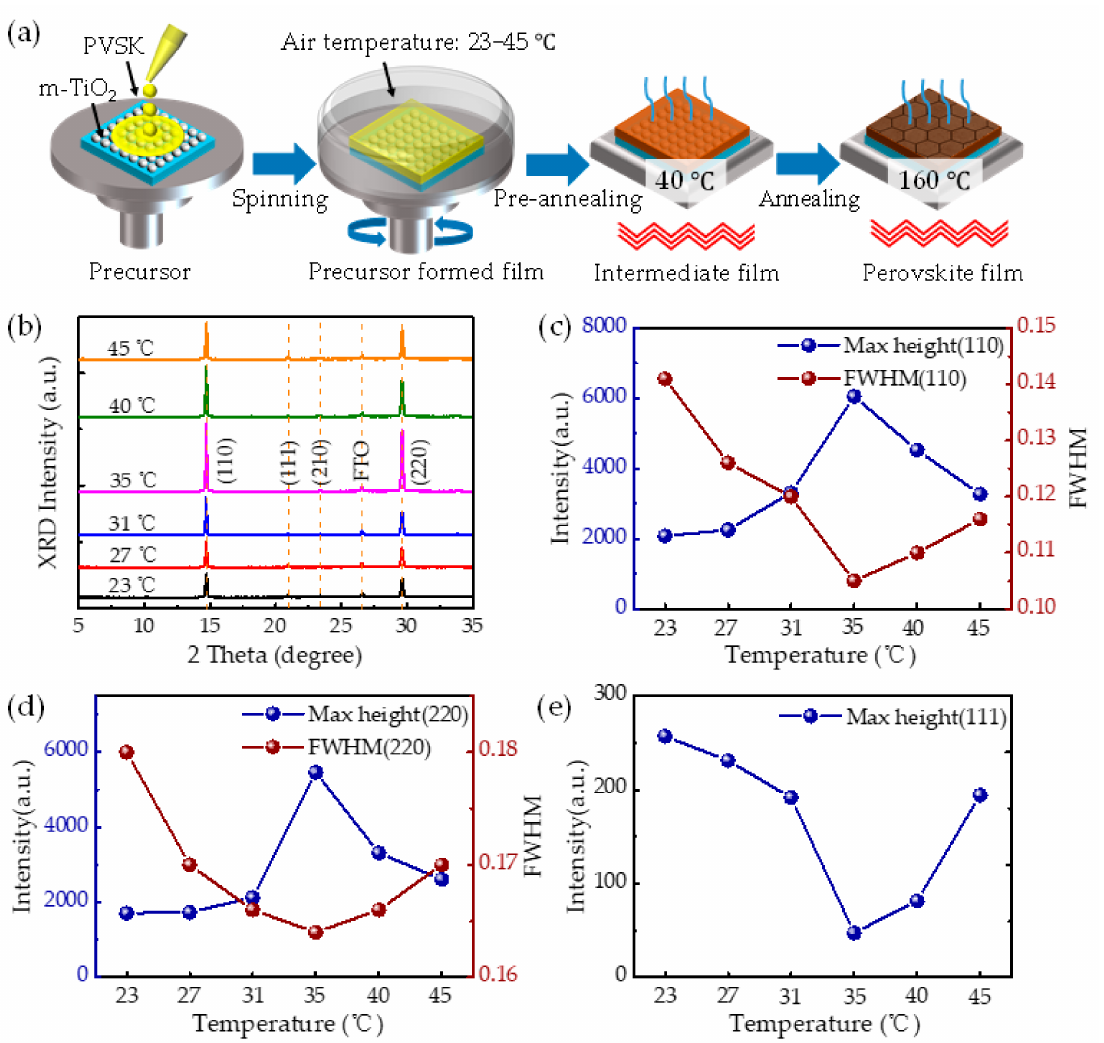
Figure 1. ( a ) Ambient air temperature assisted crystallization procedure of perovskite films. ( b ) X-ray diffraction patterns of the as-prepared films at different ambient temperatures. ( c – e ) Intensity and FWHM evolution of (110), (220), and (111) planes of perovskite films as the function of the ambient